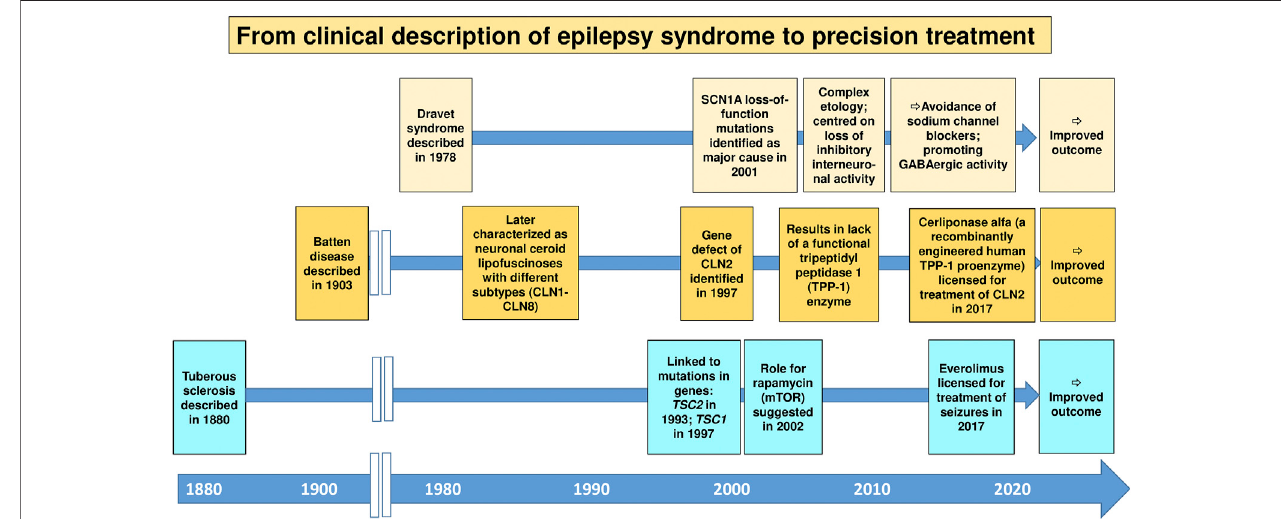
FIGURE 6 | The historical development of precision medicine, i.e., the treatment of patients with therapy targeted to their speci fi c pathophysiology, for genetic epilepsies. Three important examples are shown. For details, see Sisodiya (2021) and Specchio et al. (2020).